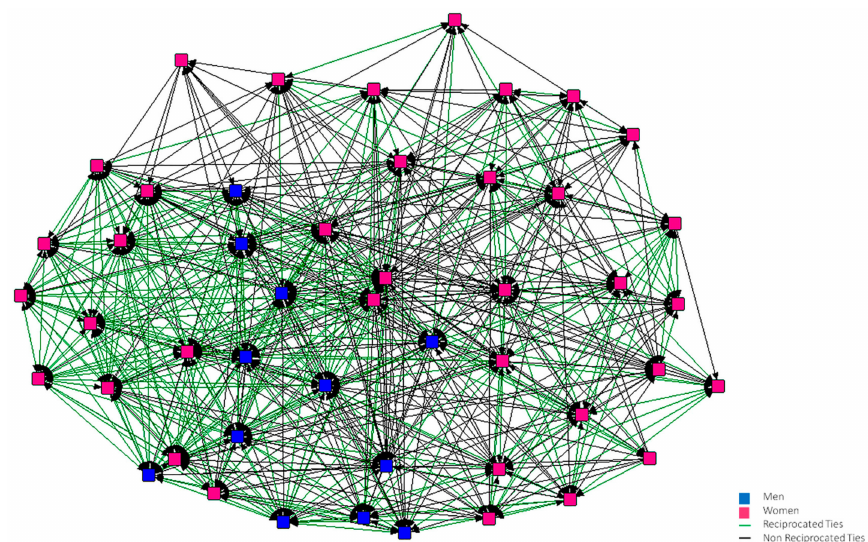
Figure 1. Graph of the first year Support Network.